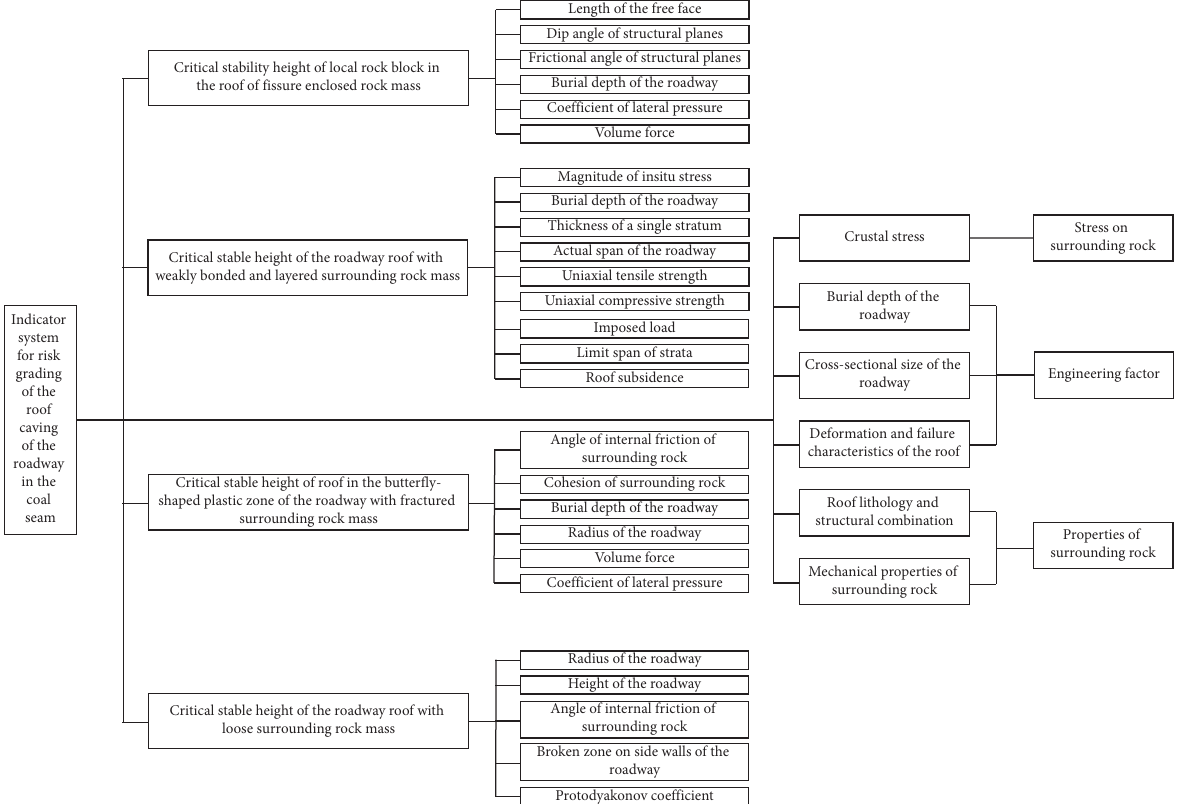
Figure 11: Indicator system for grading risk of the roof of the roadway in the coal Table 1: Grading and characteristics of roof stability.